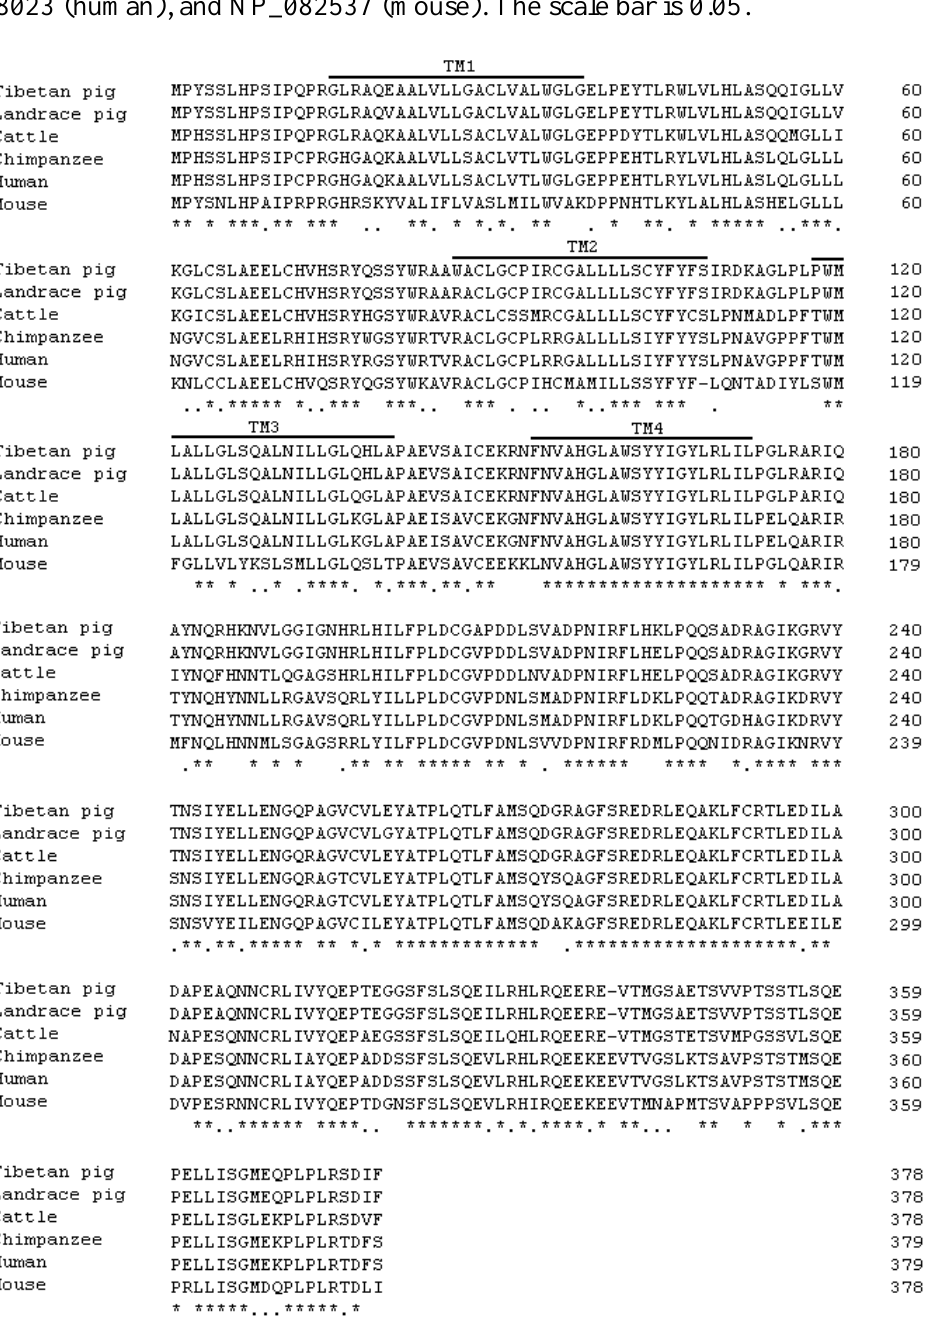
Figure 1. Alignment, phylogenetic tree, and architecture of the predicted amino acid sequence for Tibetan porcine STING. ( A ) Multiple comparison of amino acid sequences of Tibetan pig, Landrace pig, chimpanzee, cattle, human and mouse STING. Four putative transmembrane regions (TM) of Tibetan porcine STING are indicated by bold lines. The numbers on the right of every line refer to positions of the amino acid residues; ( B ) Phylogenetic analysis of Tibetan porcine STING. The neighbor-joining tree was constructed by DNAMAN. The sequences were derived from the predicted amino acid sequences of Tibetan porcine STING (AEL97644) and the GenBank entries with